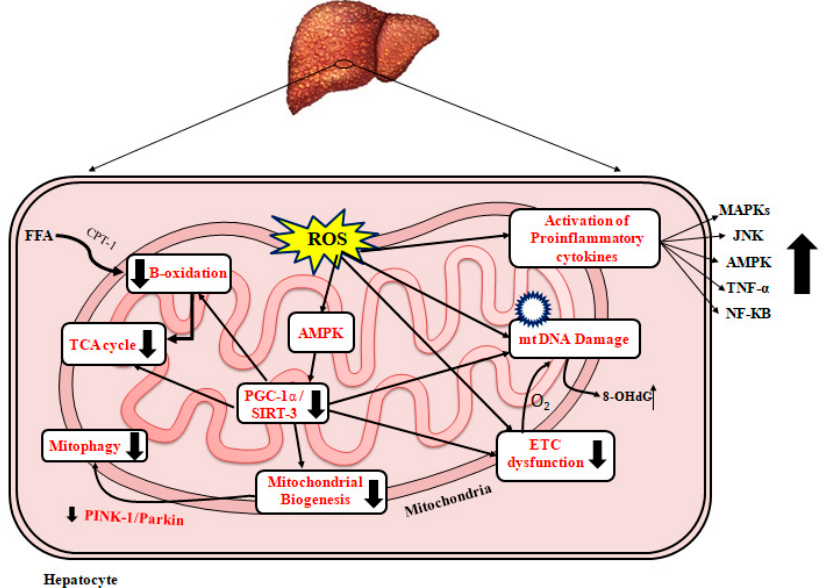
Figure 2. Mitochondrial dysfunction and NAFLD. A schematic diagram representing the effect of oxidative stress leading to mitochondrial dysfunction in liver leading to NAFLD. FFA: free fatty acid; TCA: tricarboxylic acid cycle; ROS: reactive oxygen species; CPT-1: carnitine palmitoyl transferase 1; AMPK: AMP-activated protein kinase; PGC-1 α : peroxisome proliferator-activated receptor-alpha; ETC: electron transport chain; SIRT3: sirtuin 3; MAPKs: mitogen-activated protein kinase; TNF- α : tumor necrosis factor- α ; NF- К B: nuclear factor- К B, IL: Interleukin; JNK: c-jun N terminal kinase; 8-hydroxydeoxyguanosine; O 2 : oxygen; Pink: PTEN-induced kinase 1.